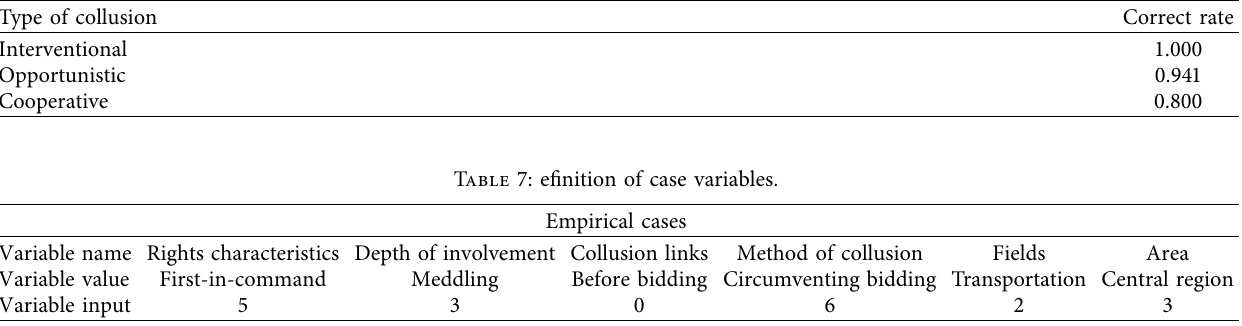
Table 6: Classification correct rate of three types of collusion.